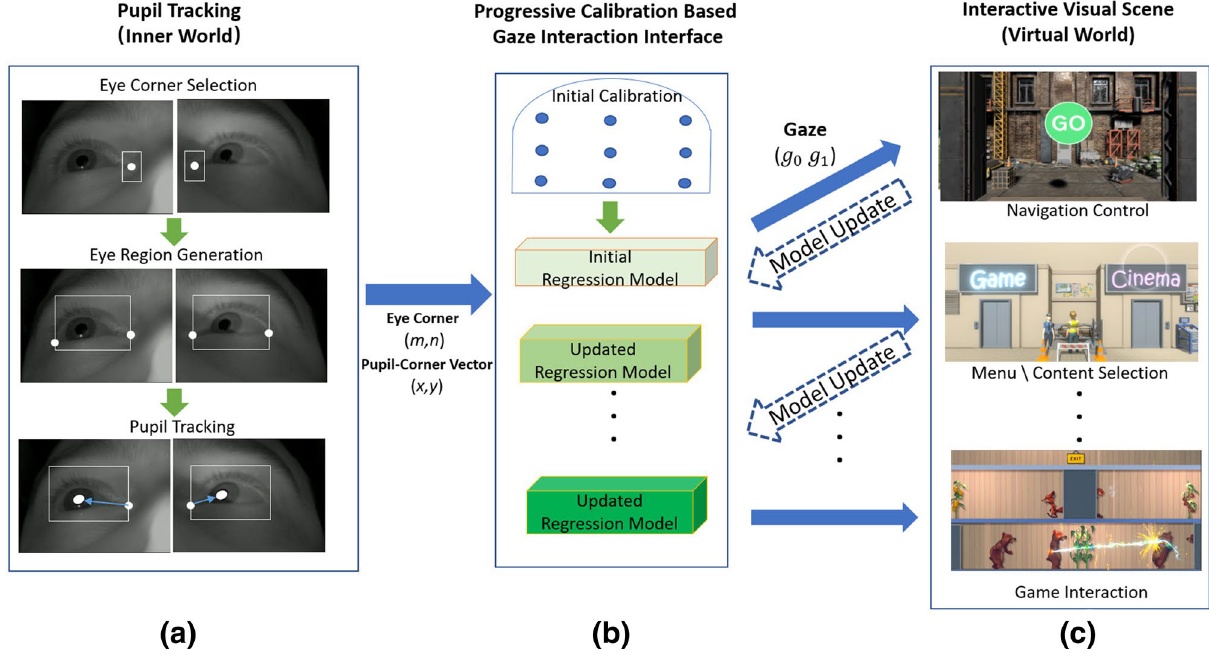
Figure 3. Illustration of the system pipeline: the eye tracking stage tracks the eye corner and pupil location for each eye. The gaze estimation module uses the eye tracking results to build an initial regression model which is then updated by interactive calibration. The gaze information is fed into the VR system to trigger interactions. Interactive progressive calibration is executed in the background when interactions are triggered. This mechanism can progressively improve the gaze regression model accuracy without changing the user